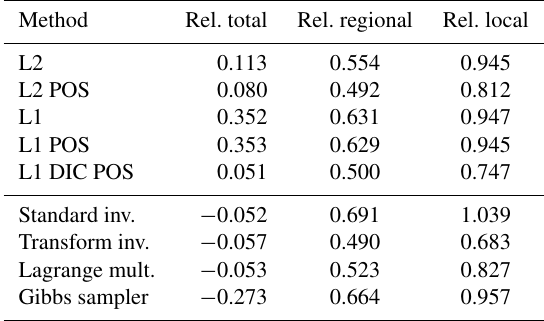
Table 1. Reconstruction errors measured on local, regional, and to- tal scales (see Eqs. 16–18). For the total, a negative sign means over- estimation. The regional and local measures are always positive. All measures are relative and thus without